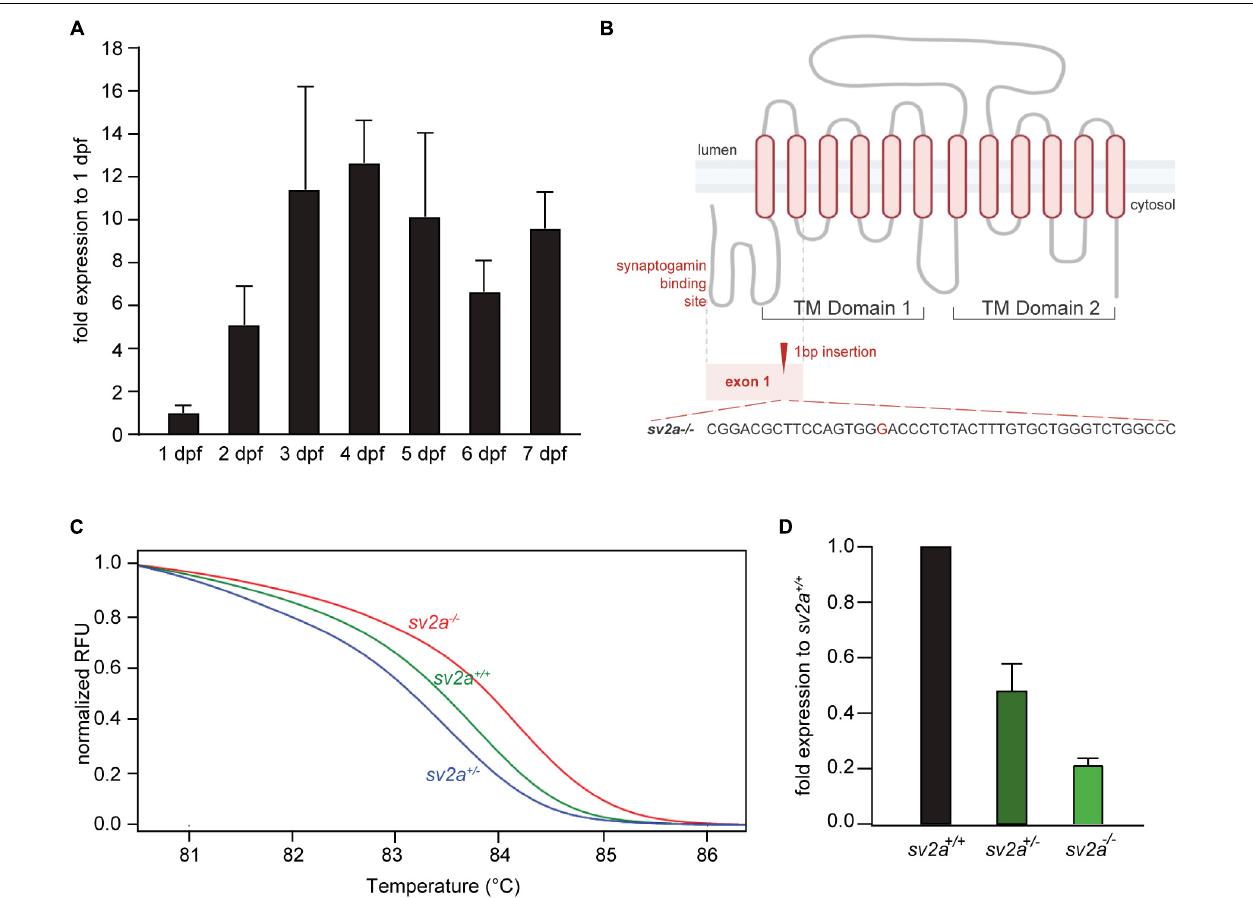
FIGURE 1 | sv2a expression in developing zebrafish larvae (1-7 dpf) and CRISPR-mediated sv2a knockout in zebrafish. (A) qPCR analysis of sv2a mRNA levels in wildtype larvae normalized to 18s and represented as the fold expression to 1 dpf. Values are reported as mean ± SD of three independent experiments. (B) Schematic representation of the SV2A protein with the two distinct transmembrane (TM) domains and the cytosolic synaptogamin binding site. Gray dashed line indicates exon 1 encoding synaptogamin binding domain and the first two TM helices. Red dashed line magnifies the region with the 1 nucleotide insertion (G) at the target site in exon 1. (C) High resolution melting (HRM) curve analysis discriminates sv2a + / + , sv2a + / − , and sv2a − / − zebrafish larvae at 6 dpf. (D) qPCR analysis of sv2a mRNA levels in sv2a + / + , sv2a + / − , and sv2a − / − larvae at 6 dpf normalized to 18s and represented as the fold expression to sv2a + / + larvae. Values are reported as the mean ± SD of three independent